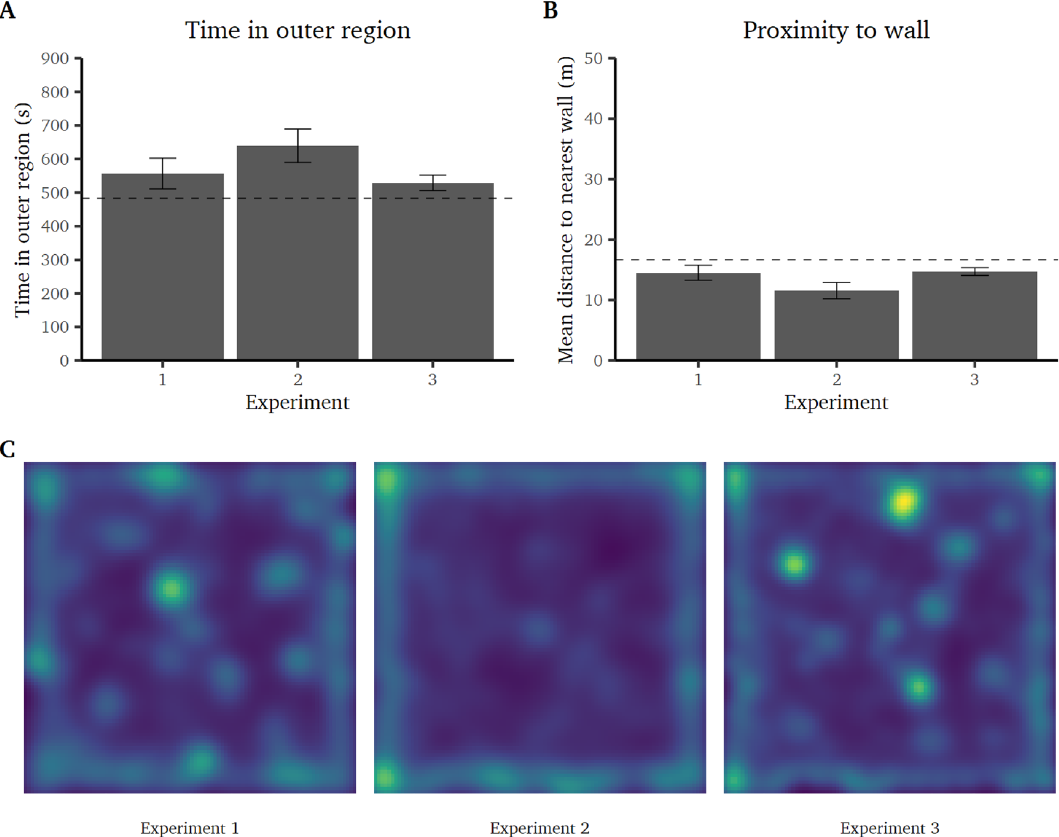
Figure 3. ( A ) Mean time (in seconds) spent in the outer region of the open field in experiments 1–3 (± 95% CI; indicates significance if the CI does not include the expected value of 483.40 s (dashed line)). ( B ) Mean distance (in meters) to the nearest wall of the open field in experiments 1–3 (± 95% CI; indicates significance if the CI does not include the expected value of 16.67 m (dashed line)). ( C ) Heatmaps of the positioning data of all participant in experiments 1–3. Shading indicates the time spent in the respective position across all participants (the brighter, the more time spent in the respective